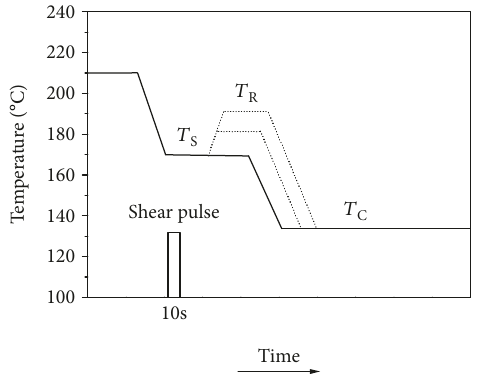
Figure 1: Schematic diagram of the temperature-shear